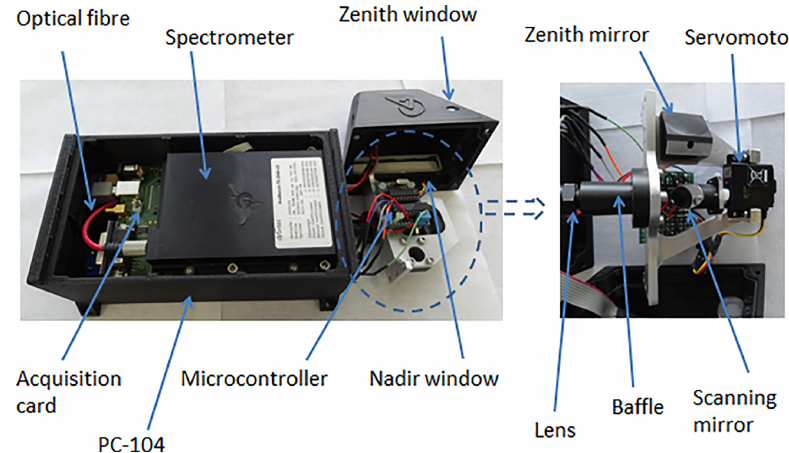
Figure 2. The SWING instrument. Its dimensions are 27cm × 12cm × 8cm and its weight is 920g.